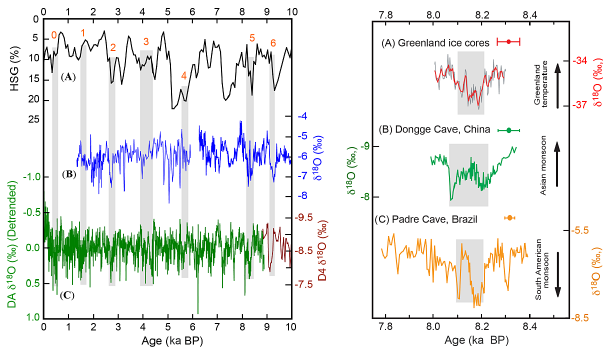
Figure 11. Left: comparison of Bond events in the North Atlantic, Asian monsoon and South American monsoon records (adapted from Stríkis et al., 2011; Cheng, 2012a). (a) Hematite stained quartz grain (HSG) record from North Atlantic deep-sea core VM 29–191 (Bond et al., 1997). (b) South American monsoon record from Lapa Grande Cave in central–eastern Brazil (Stríkis et al., 2011). (c) Asian monsoon δ 18 O record from two stalagmites, DA (green, de- trended) and D4 (brown) from Dongge Cave, southeastern China (Y. Wang et al., 2005; Dykoski et al., 2005). Gray bars indicate apparent Bond events 0–6 in monsoon regions. Right: paleocli- mate records over the 8.2kaBP event (modified from Cheng et al., 2009b). (a) Stacked composite δ 18 O data of Greenland ice cores (Dye3, GRIP, GISP2, and NGRIP; resolution of ∼ 2.5 years in gray and four-point average in red; Thomas et al., 2007). (b) DA, Dongge Cave, China (Cheng et al., 2009a). (c) PAD07, Padre Cave, Brazil (Cheng et al., 2009b). The δ 18 O scales are reversed for the Dongge record (increasing down) for comparison with the South American monsoon record. Arrows depict anti-phase changes between South American monsoon and Asian monsoon–Greenland temperature. Color-coded error bars indicate typical dating errors (2 σ ) for each record around the 8.2kaBP